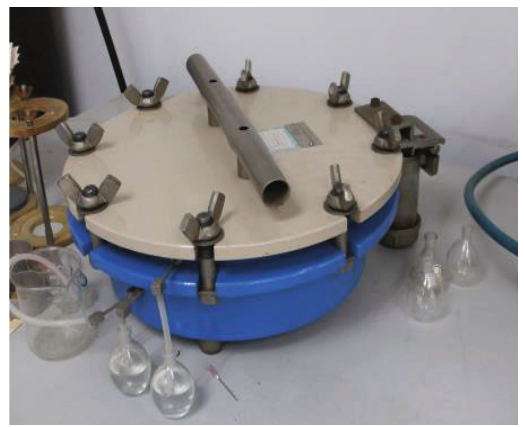
Figure 2: Unsaturated soil pressure